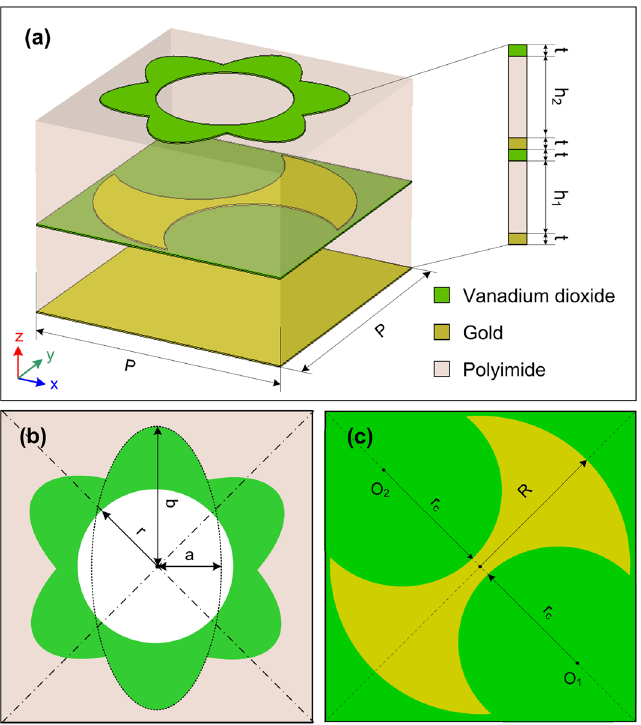
Figure 2. The proposed RMS: ( a ) 3D-model, ( b ) top-view of resonant patch for ABS mode, and ( c ) top-view of resonant patch for PC